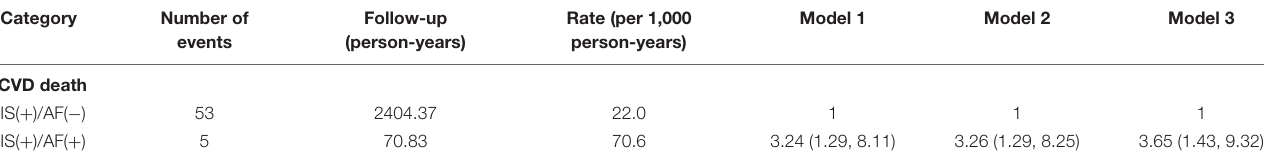
TABLE 5 | Rates and rate ratios with 95% CI of CVD mortality according to the prevalence at baseline. Category Number of Follow-up Rate (per 1,000 events (person-years)